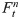
Evaluation on the resistance of accuracy measures to a single forecasting outlier.A: Synthetic time series data where Yt is the target series and Ftn are forecasts. The only difference between Ftn is their forecasts on the observation Y8. B: Results of single forecasting outlier evaluation, which shows UMBRAE is less sensitive than other measures to a single forecasting outlier.